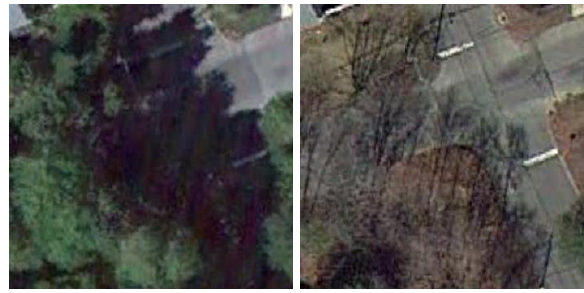
Figure 1. Example of season specific object changes